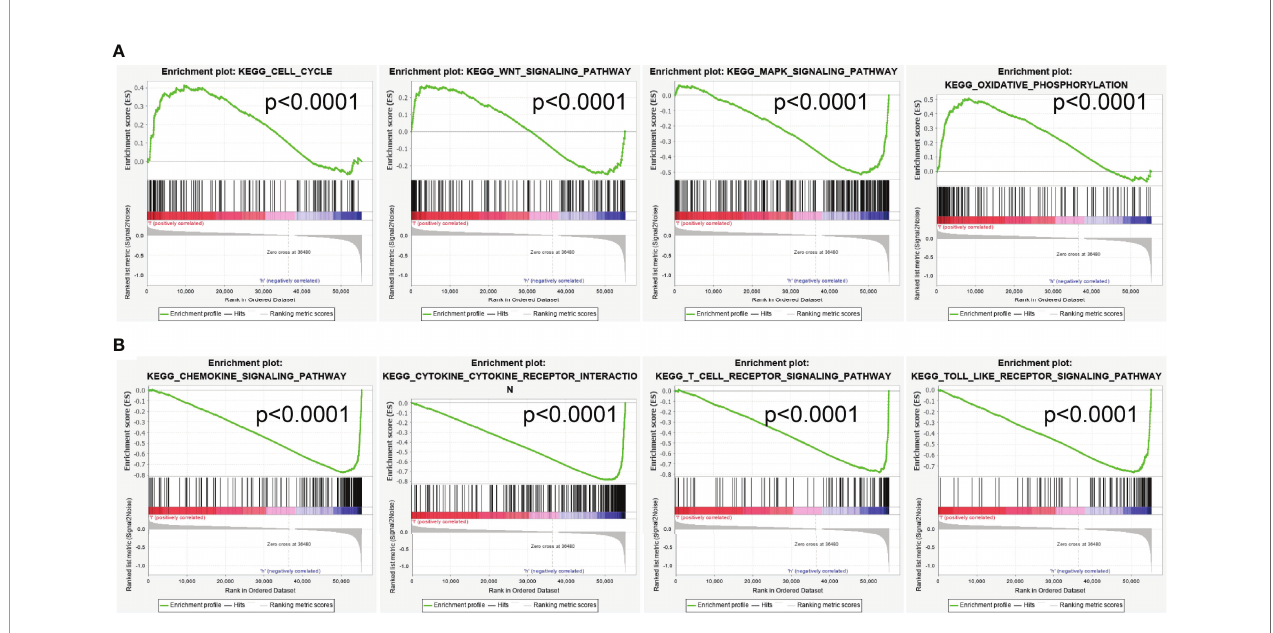
FIGURE 8 | GSEA of SASH3. (A, B) The top GSEA results in pan-cancer.